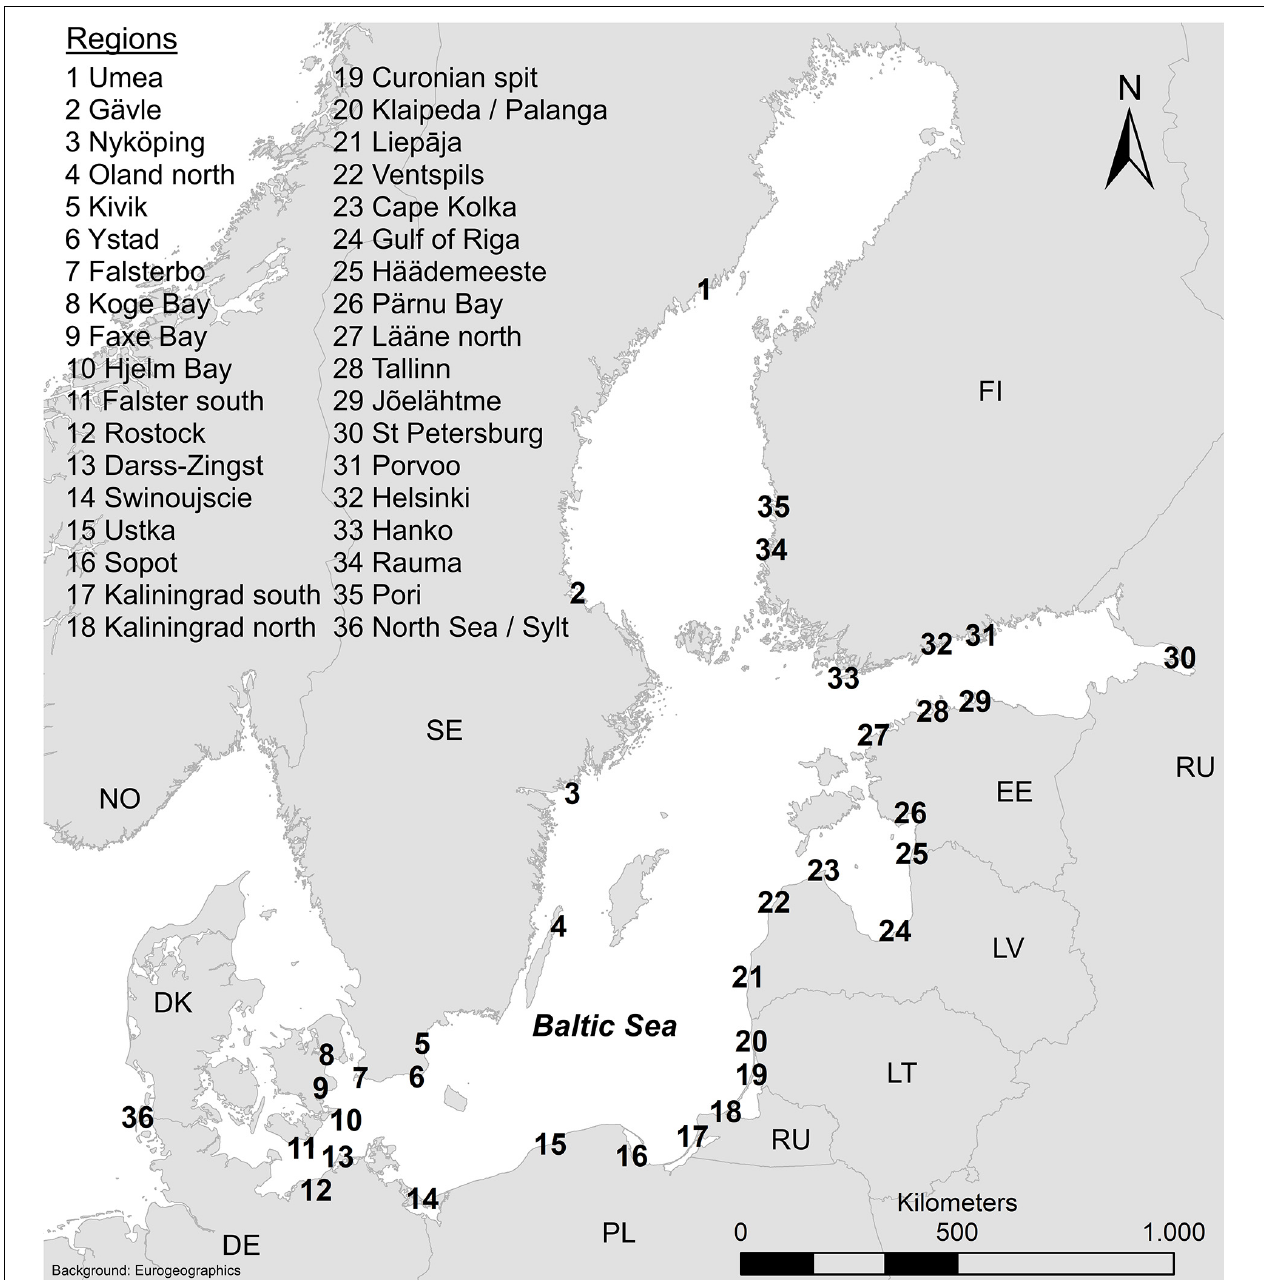
FIGURE 1 | Overview map of the Baltic Sea and part of the North Sea with the 36 survey regions (Eurogeographics,